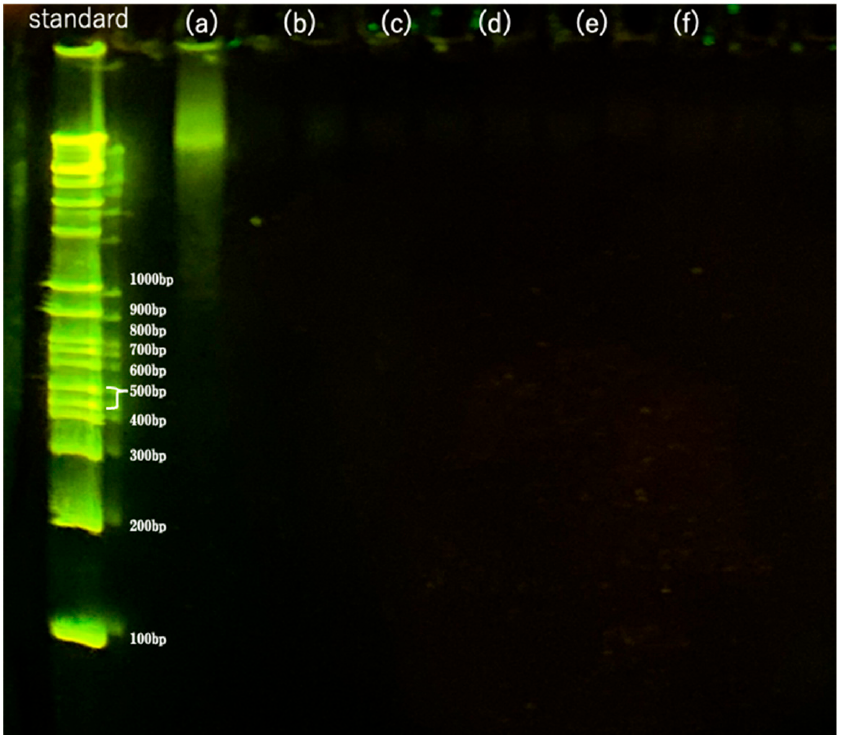
Figure 9. Fragments of residual DNA in the samples as detected by agarose gel electrophoresis. ( a ) Untreated. ( b – f ) DNase treatment for ( b ) 1, ( c ) 3, ( d ) 5, ( e ) 7, and ( f ) 10 days following DME extrac- tion.